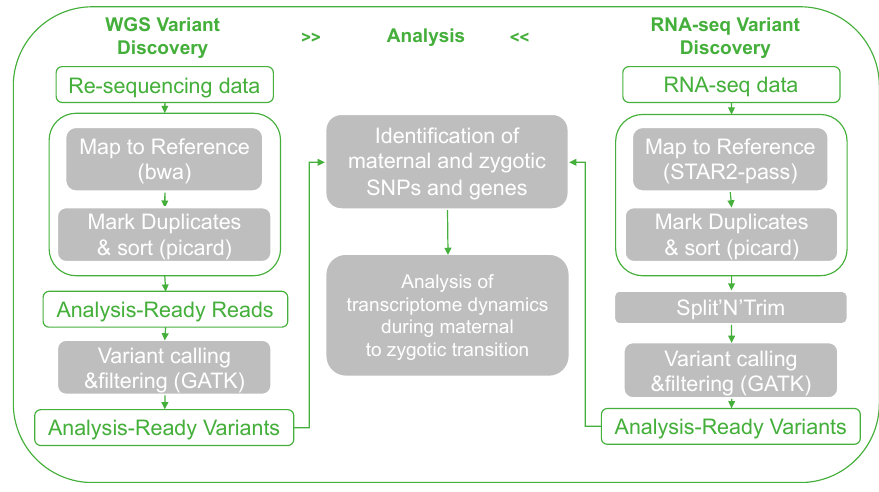
Figure 2. Pipeline for identification of maternal and zygotic SNPs and genes.